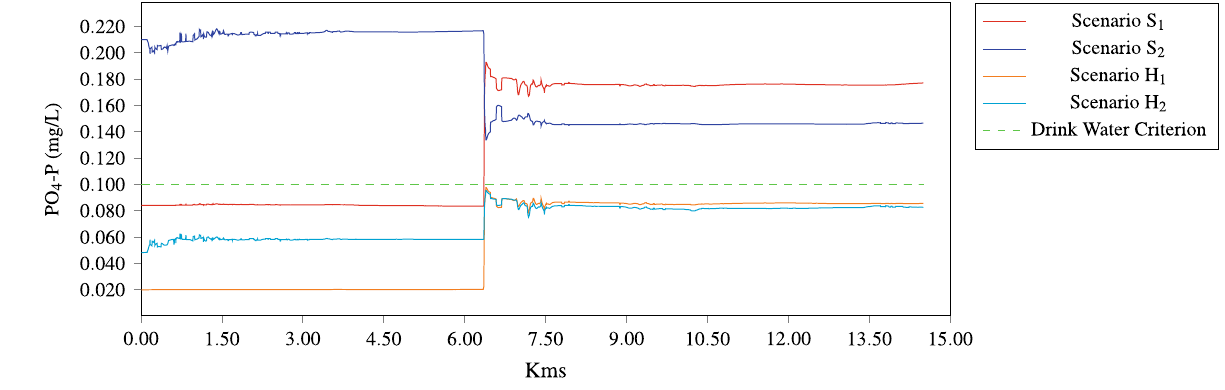
Figure 10. Concentration of PO 4 -P along the river when the hydrodynamic is steady.